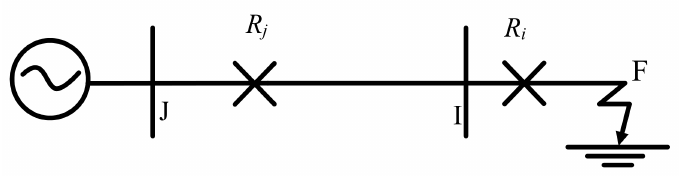
Figure 1. A single-end radial distribution system.